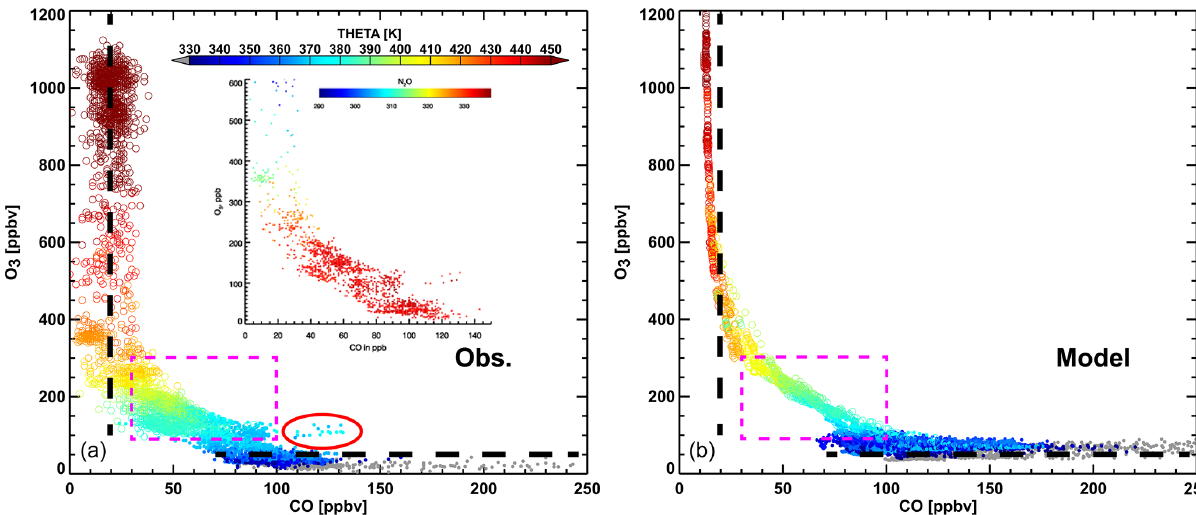
Figure 5. O 3 vs. CO relationships in tracer–tracer space based on observations (a) and WACCM simulations (b) for the 2017 Kathmandu flights. The data points are coloured according to their potential temperature level (with grey indicating θ< 330K), and they are shown by two types of symbols for above (circle) and below (dots) the LRT. WACCM grid points are selected to match the flight dates and are sampled in grid points nearest to the flight track (within ± 1 ◦ in latitude and longitude) to minimize spatio-temporal offsets. Dashed lines indicate three “regimes” identified by the O 3 –CO relationship, corresponding to the troposphere (horizontal dashed line), the stratosphere (vertical dashed line) and the transition layer (magenta rectangle). We chose criteria of 30ppb < CO < 100ppb and 80ppb < O 3 < 300ppb to assign measurements to the transition layer (i.e. both gases having neither tropospheric nor stratospheric values). The points marked by the red oval are likely produced by convective transport and O 3 production from lightning NO x (see text). The inset in (a) shows the observed O 3 vs. CO relationship coloured according to quasi-simultaneous N 2 O observations (points are only displayed if the time of measurement is within 30s of a HAGAR N 2 O measurement and if the difference in θ at the times of CO / O 3 and N 2 O measurements is less than 2.5K).